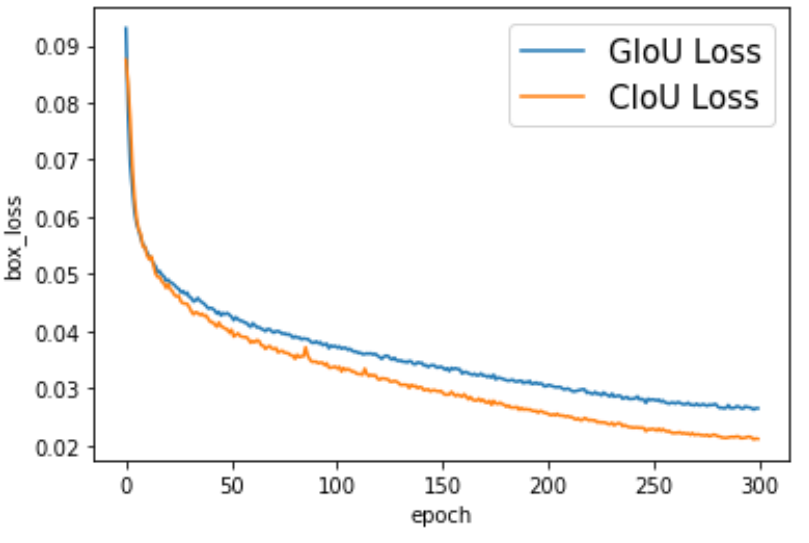
Figure 7. Variation in the two loss functions.